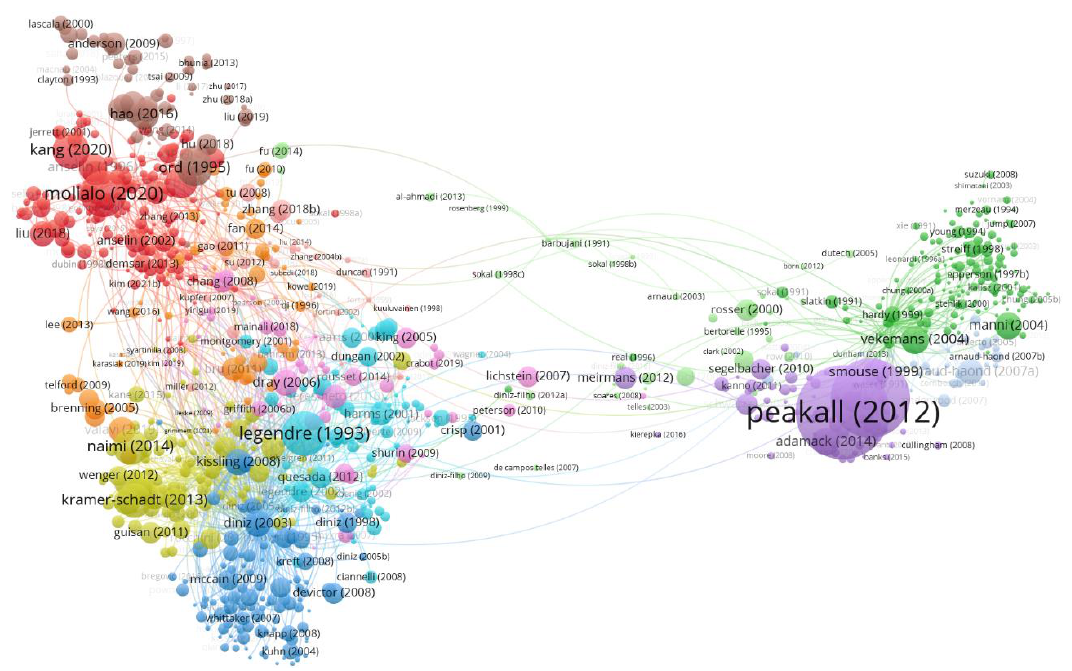
Figure 9. Paper citations map by VOSviewer. (The weight for node size is still normalized cita- tions).